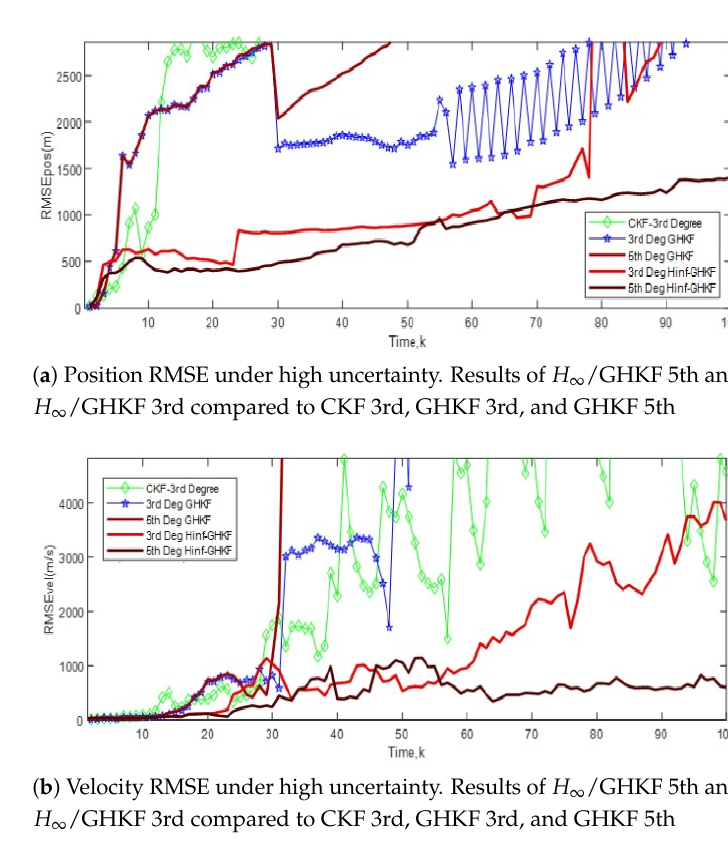
Figure 34. Comparing the performance of target tracking algorithms. This study focused on compar- ing the performance of non-linear filters for estimating the location and velocity of a moving emitter based on TDOA and FDOA measurements. The comparison shows that the H ∞ /GHKF is better than other conventional filters